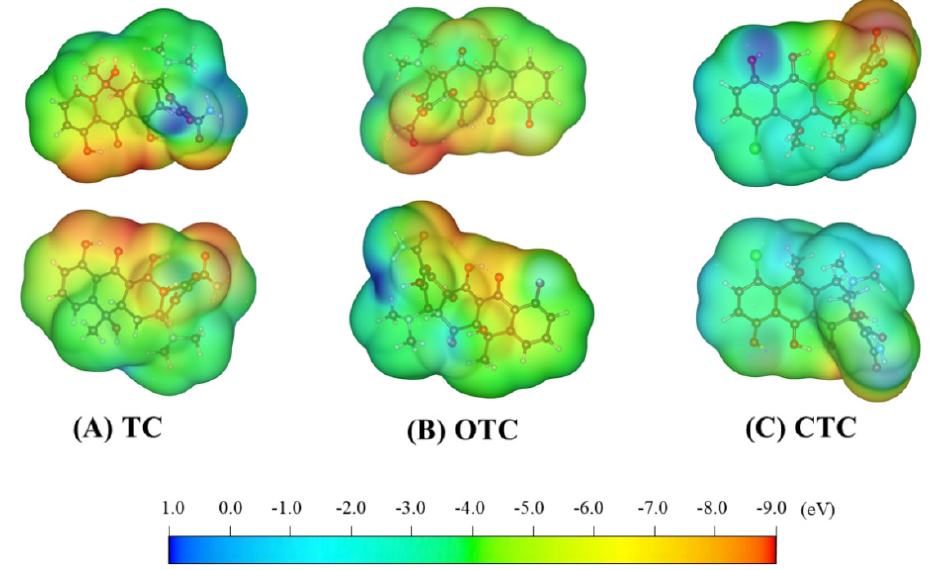
Figure 2. ESPs of ( A ) TC, ( B ) OTC, and ( C ) CTC molecules (two-side view). The blue area represents a positive ESP exhibiting electrophilic properties, whereas the red area represents a negative ESP exhibiting nucleophilic properties.